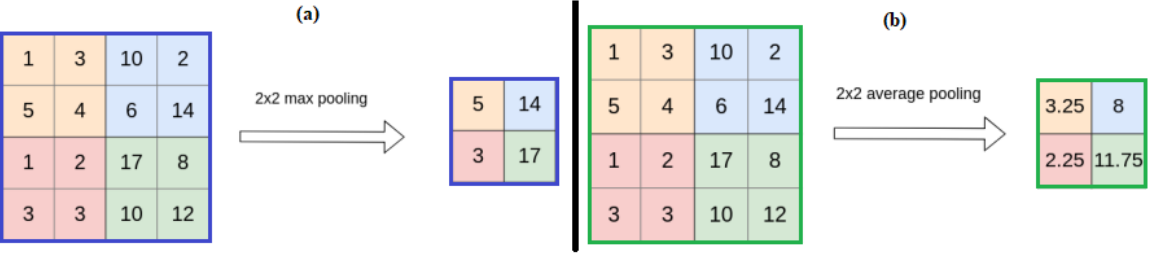
Figure 5. Pooling Operations. Adapted from Vasilev et al.